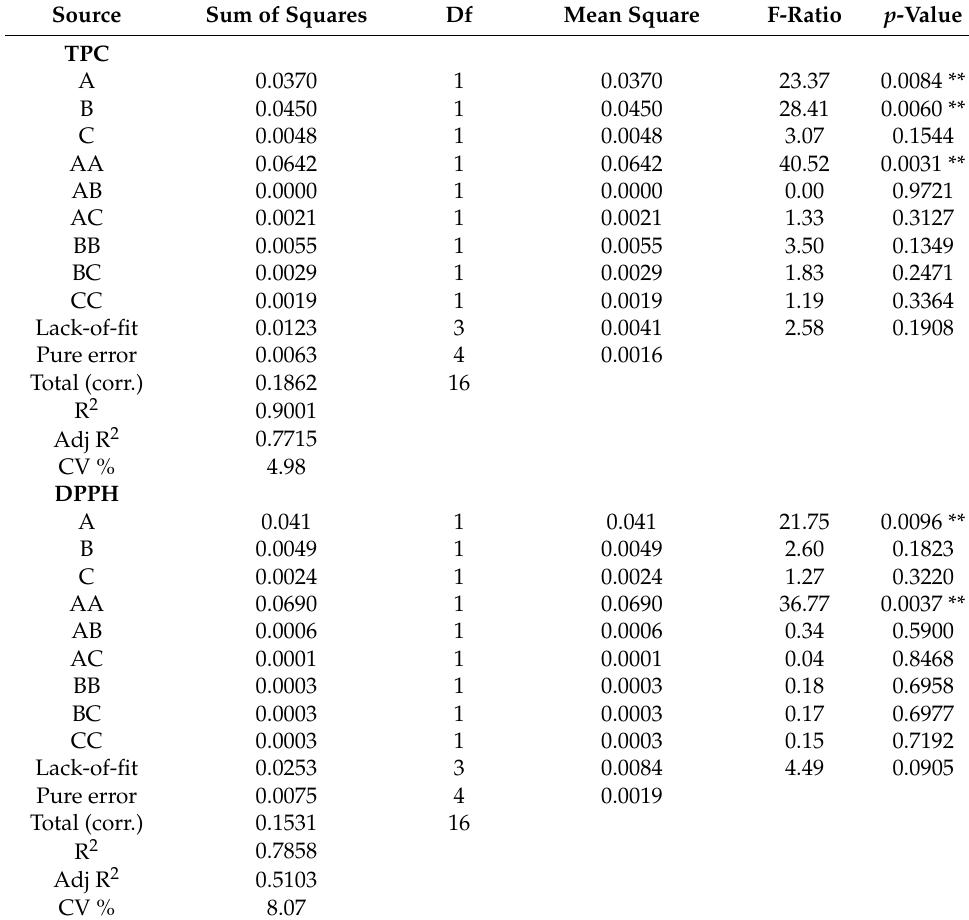
Table 4. ANOVA results for response surface quadratic models of TS extraction by